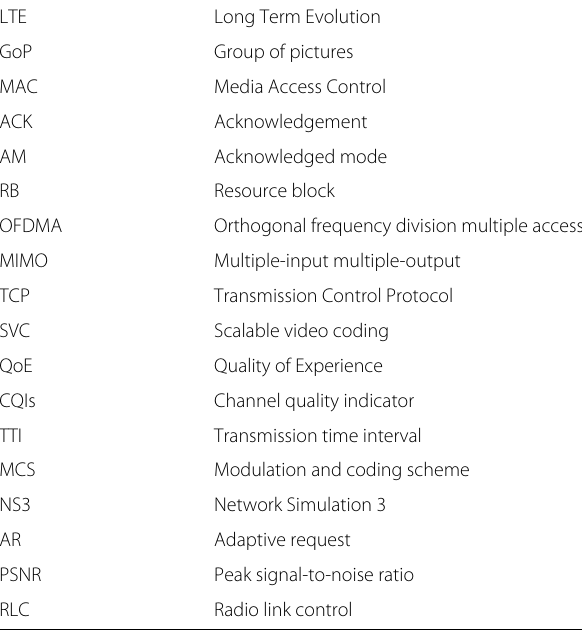
Table 1 A list of